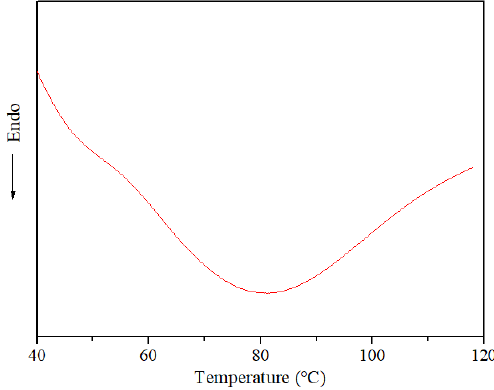
Figure 9. DSC characterization of p–DN hydrogel.